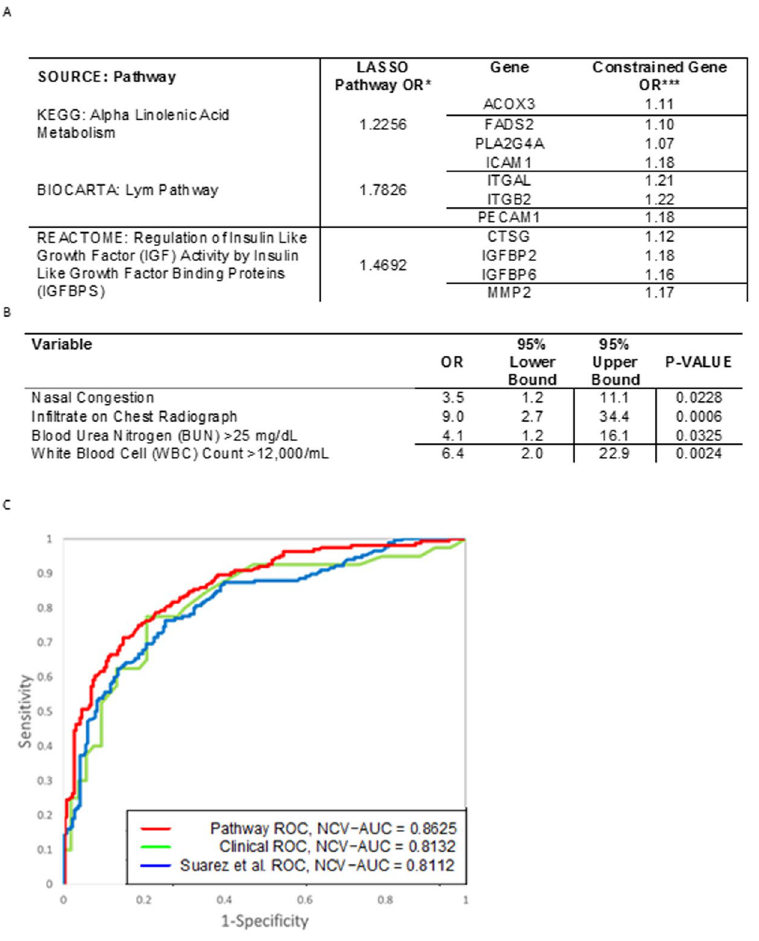
Figure 5. Comparison of Predictive Performance for Gene Expression and Clinical Biomarkers. ( A ) LASSO- penalized logistic regression retained 3 pathways consisting of a total of 11 genes providing the greatest predictive value for classifying subjects as bacterial or non-bacterial. * LASSO Pathway OR are odds ratios per SD of the hard-thresholded 1st PC of the nominally significant genes within the pathway. *** Constrained Gene OR = exp (Gene Loading * log (LASSO Pathway OR)/SDPathway) = (LASSO Pathway OR)(Gene Loading/ (SD of Pathway)). ( B) Cross-validation chose a 4-predictor model consisting of nasal congestion, infiltrates on chest radiograph, blood urea nitrogen levels and white blood cell count. ( C) Area Under the ROC Curve (AUC) characteristics are shown for fully nested cross-validated estimates using the “pathway”-selected 11 gene set, the “array”-selected 10 gene set, and the 4 clinical variables. These data indicate that our pathway-based 11-gene predictor outperforms both the clinical and array-based gene